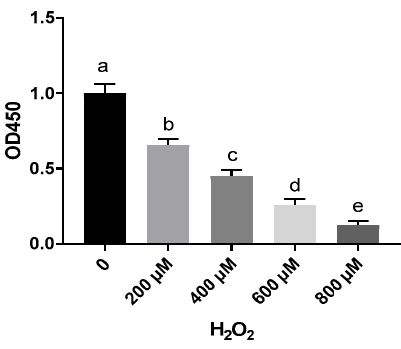
Figure 1. Hepatocytes’ survival rate detected by CCK-8 kit after being treated with 0, 200, 400, 600, and 800 µ M H 2 O 2 . One-way ANOVA with Tukey’s test was applied. Data are expressed as mean ± SD; different letters indicate significant differences ( p < 0.05).